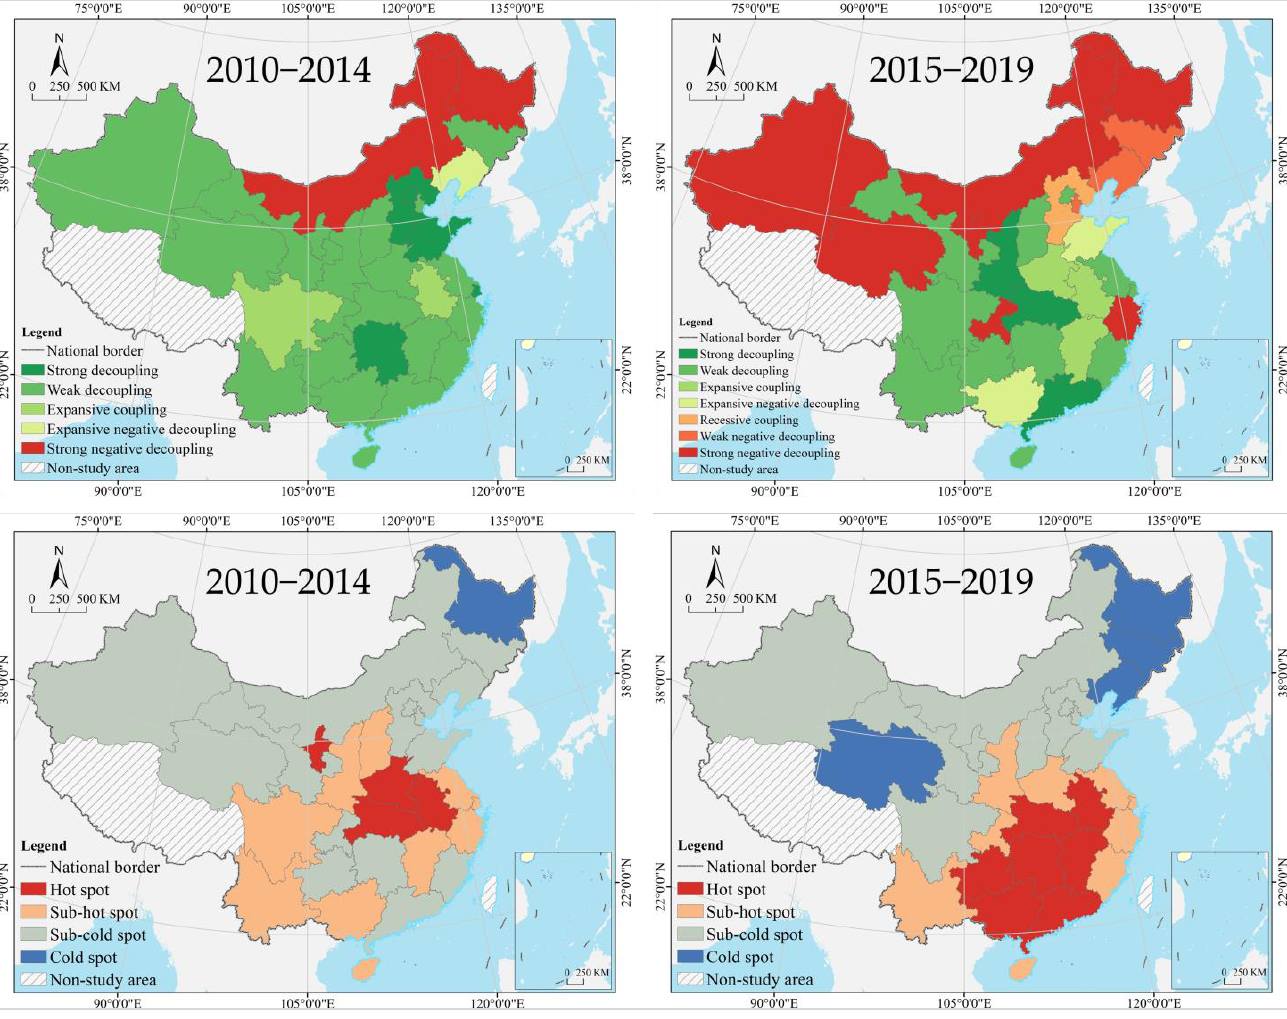
Figure 14. Spatial distribution and gathering characteristics of decoupling types between ECA and total profit.